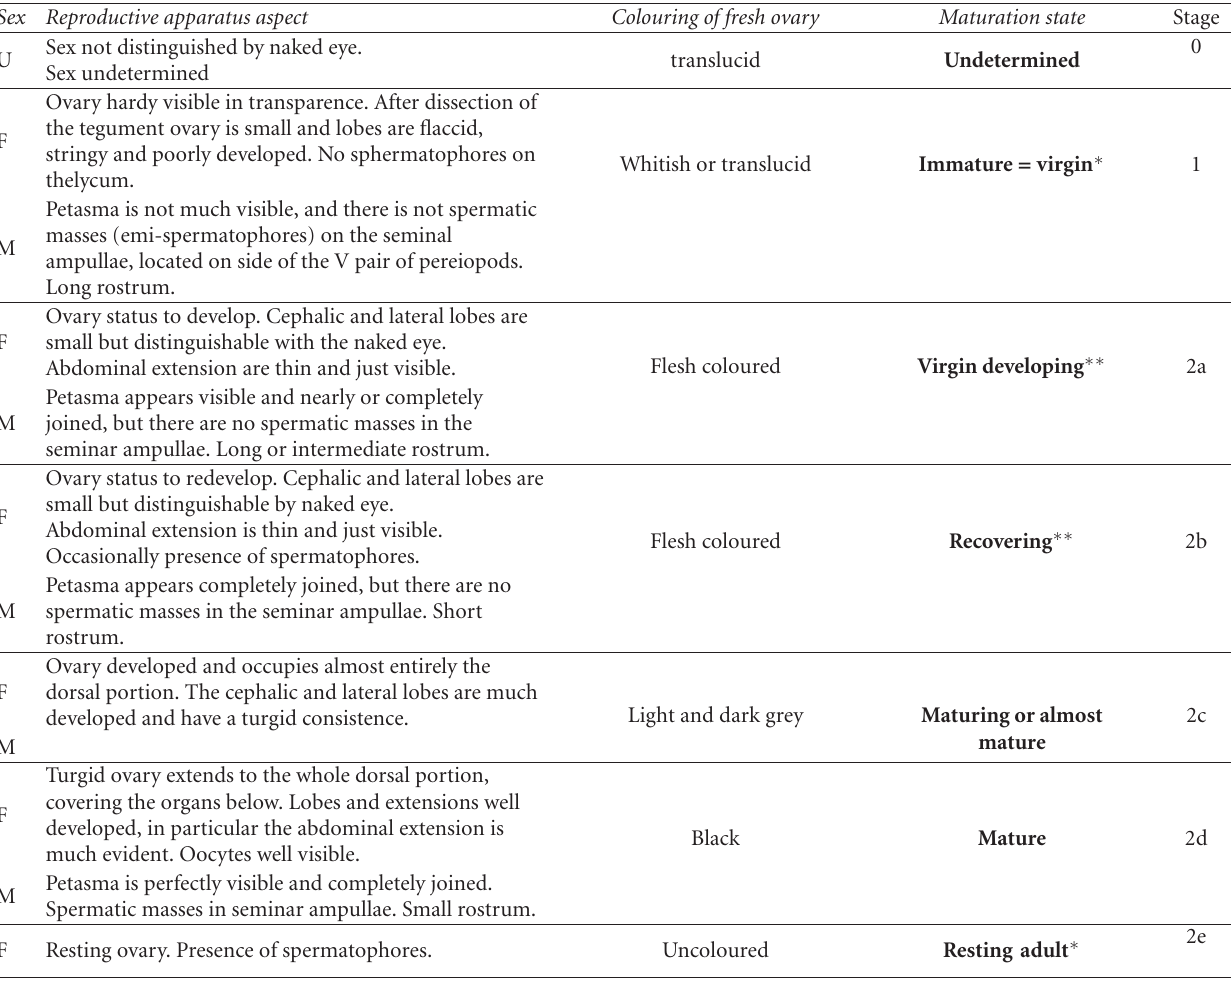
Table 1: Macroscopic maturity scale adopted in MEDITS trawl surveys (MEDITS Instruction Manual v.5.0, 2008). Sex Reproductive apparatus aspect Colouring of fresh ovary Maturation state Stage translucid Undetermined